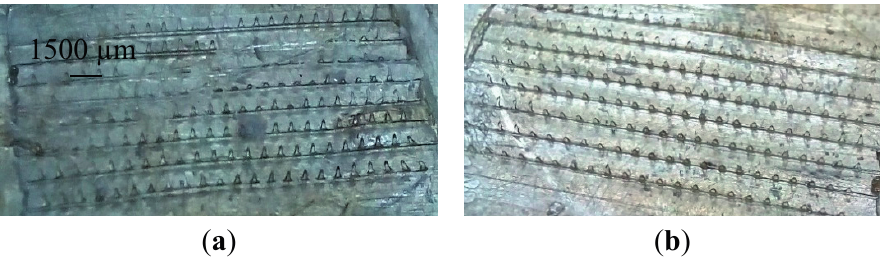
Figure 12. Digital images of ( a ) NC 20 g and ( b ) FSBP microneedles formed at 70 °C.